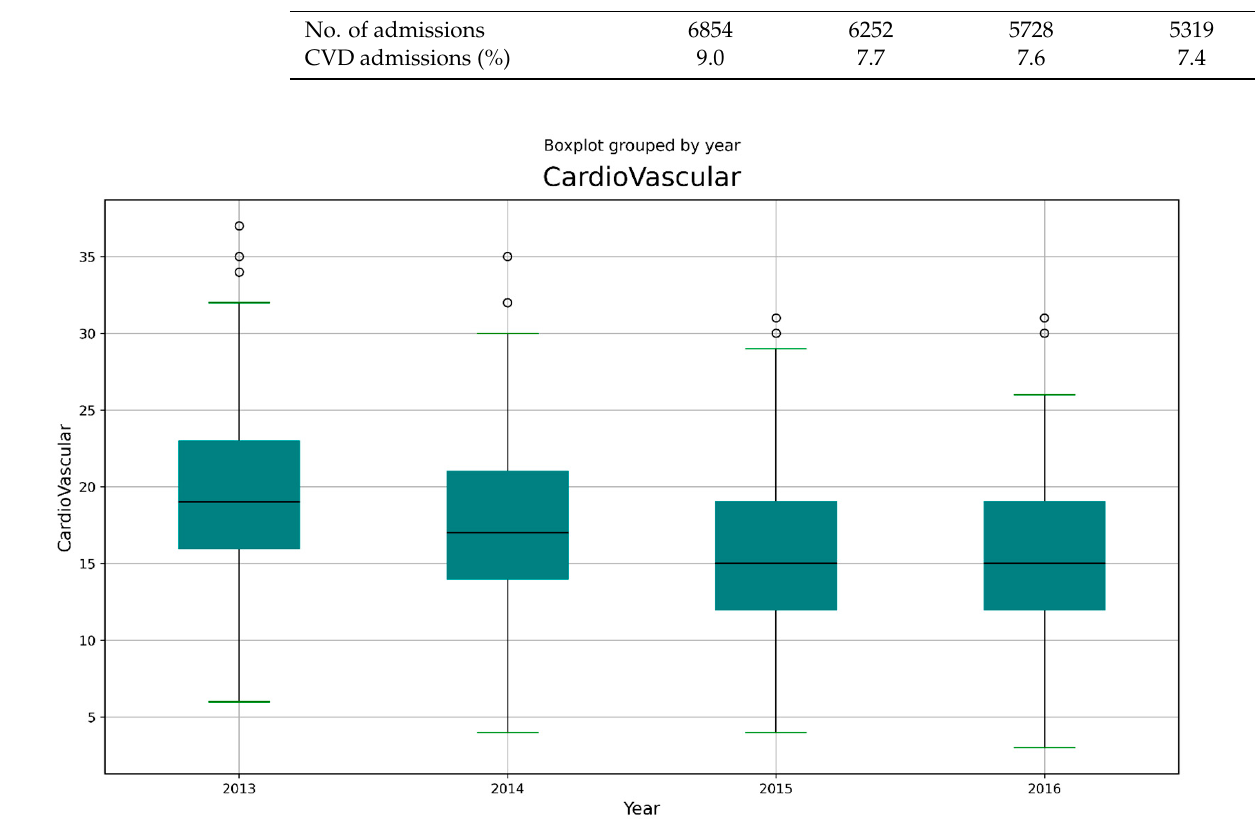
Figure 2. Boxplot of CVD admissions. Table 4. Number of admissions in ER for CVD diseases. Cardiovascular.